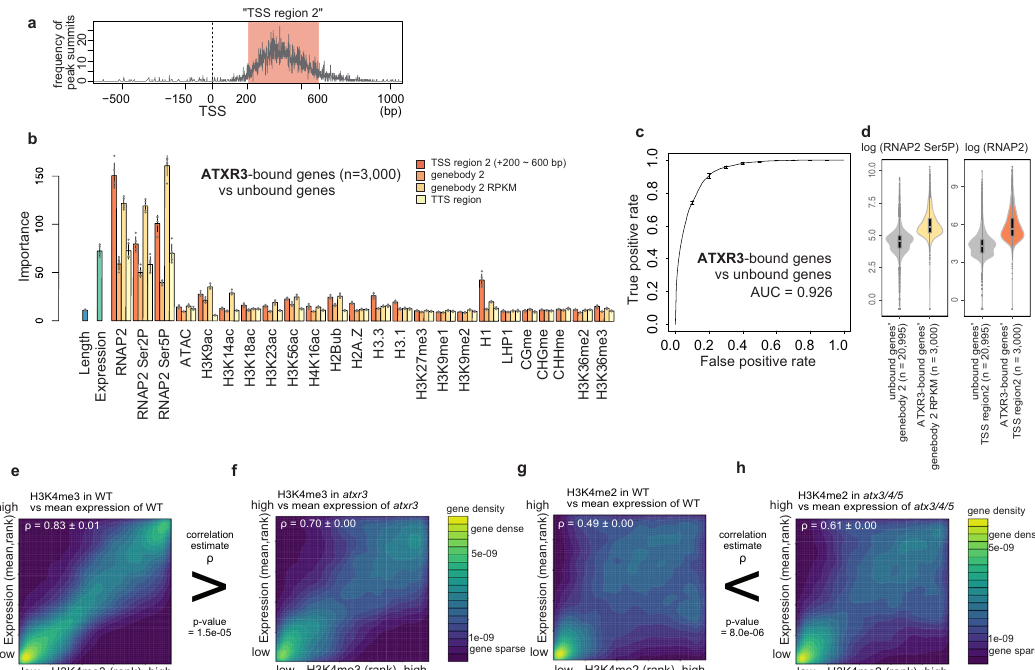
Fig. 6 | Localization and functional mode of other Arabidopsis H3K4 methyl- transferases.a PositionofATXR3peaksrelativetoTSS,visualizedasafrequencyof ChIP-seq peak summits around TSS. x -axis, distance from TSS; y -axis, number of peak summits. Most of the ATXR3 peaks belong to the region spanning from 200bpto600bpdownstreamofTSS,whichwehereafterrefertoas ‘ TSSregion2 ’ . b Chromatin features predictive of ATXR3 localization. Error bars represent the standard deviation of the 5 repeats of training. c ROC plot showing the prediction accuracyoftherandomforestmodels.AUCindicatestheareaundertheROCcurve. ROC and AUC are calculated with data on Chr 5, which are held out from the trainingastestdata.Averageandstandarddeviationofthe5repeatsoftrainingare